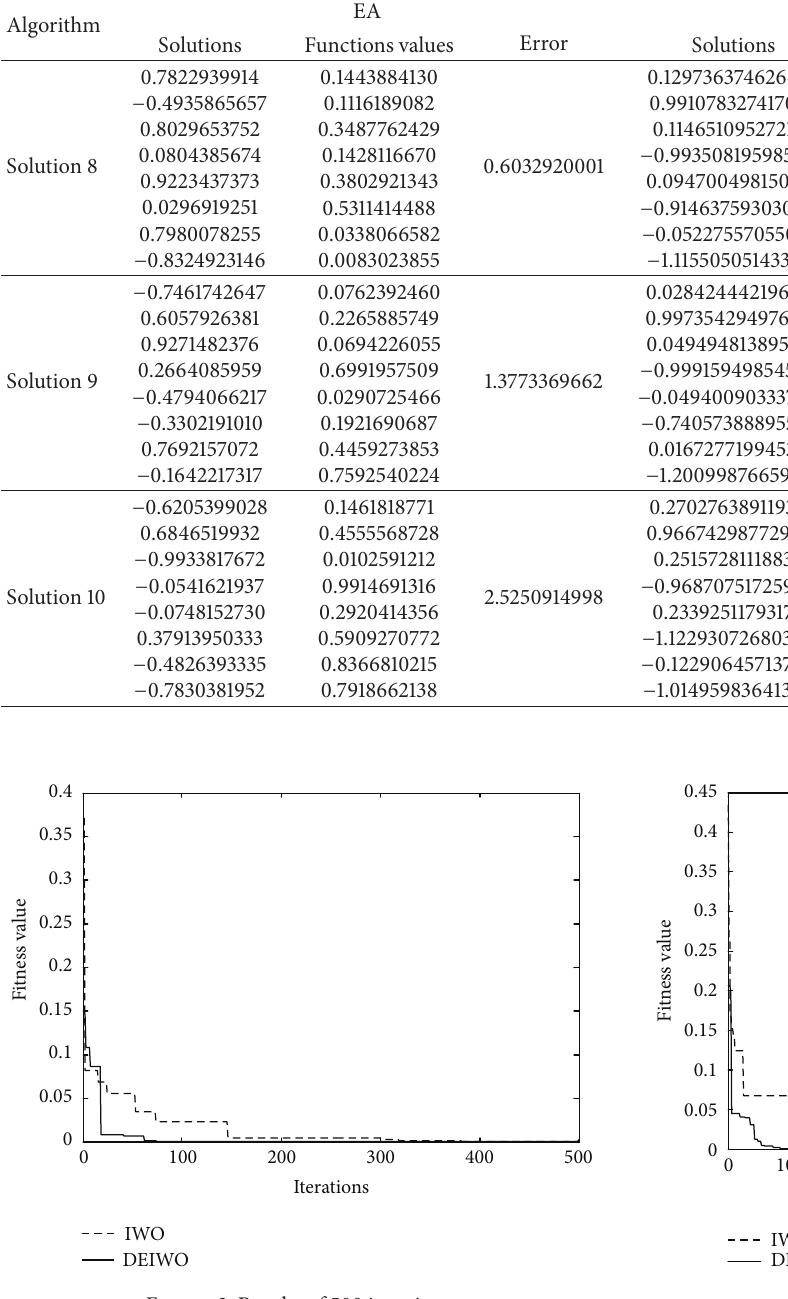
Figure 3: Results of 500 iterations. Figure 4: Results of 800